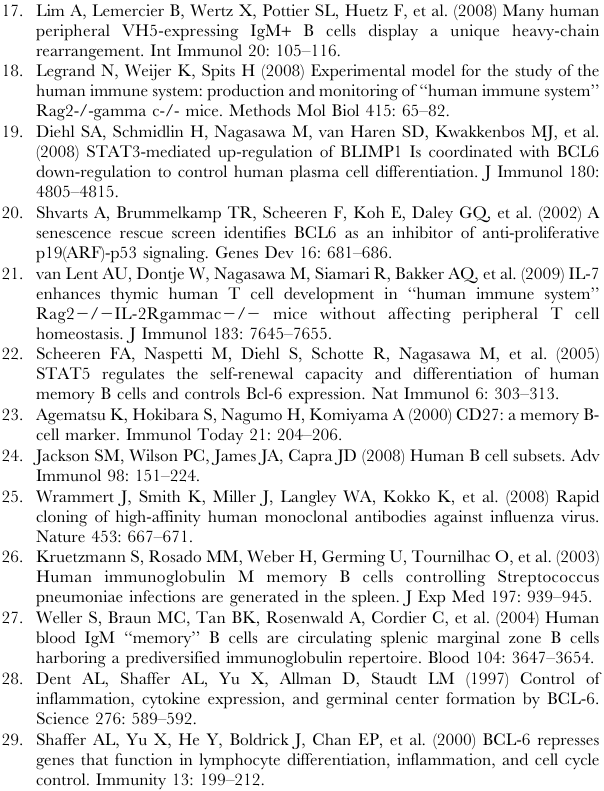
Table S2 Summary of B cell origin, sorted B cell numbers and antigen-specific B cell clone numbers. Memory B cell populations were sorted as shown in Figure 3. Limited dilutions of B cells transduced with BCL-6 and BCL-XL were performed with 6.4 and 0.64 cells/well. After sub-cloning of the positive wells, we generated 15 IgM + anti-HBsAg mAbs, of which 13 are unique (as determined by Ig-V H sequence, see Table S3), and 18 IgM + anti-TT mAbs, of which 5 are unique (see Table S4). In the case of HBsAg vaccination, the number of screened B cells was ((192*6.4) + (96*0.64))*3 =3870, which eventually suggests that the frequency of HBsAg-specific B cells is at least 1/350 B cells. Found at: doi:10.1371/journal.pone.0013137.s003 (0.13 MB